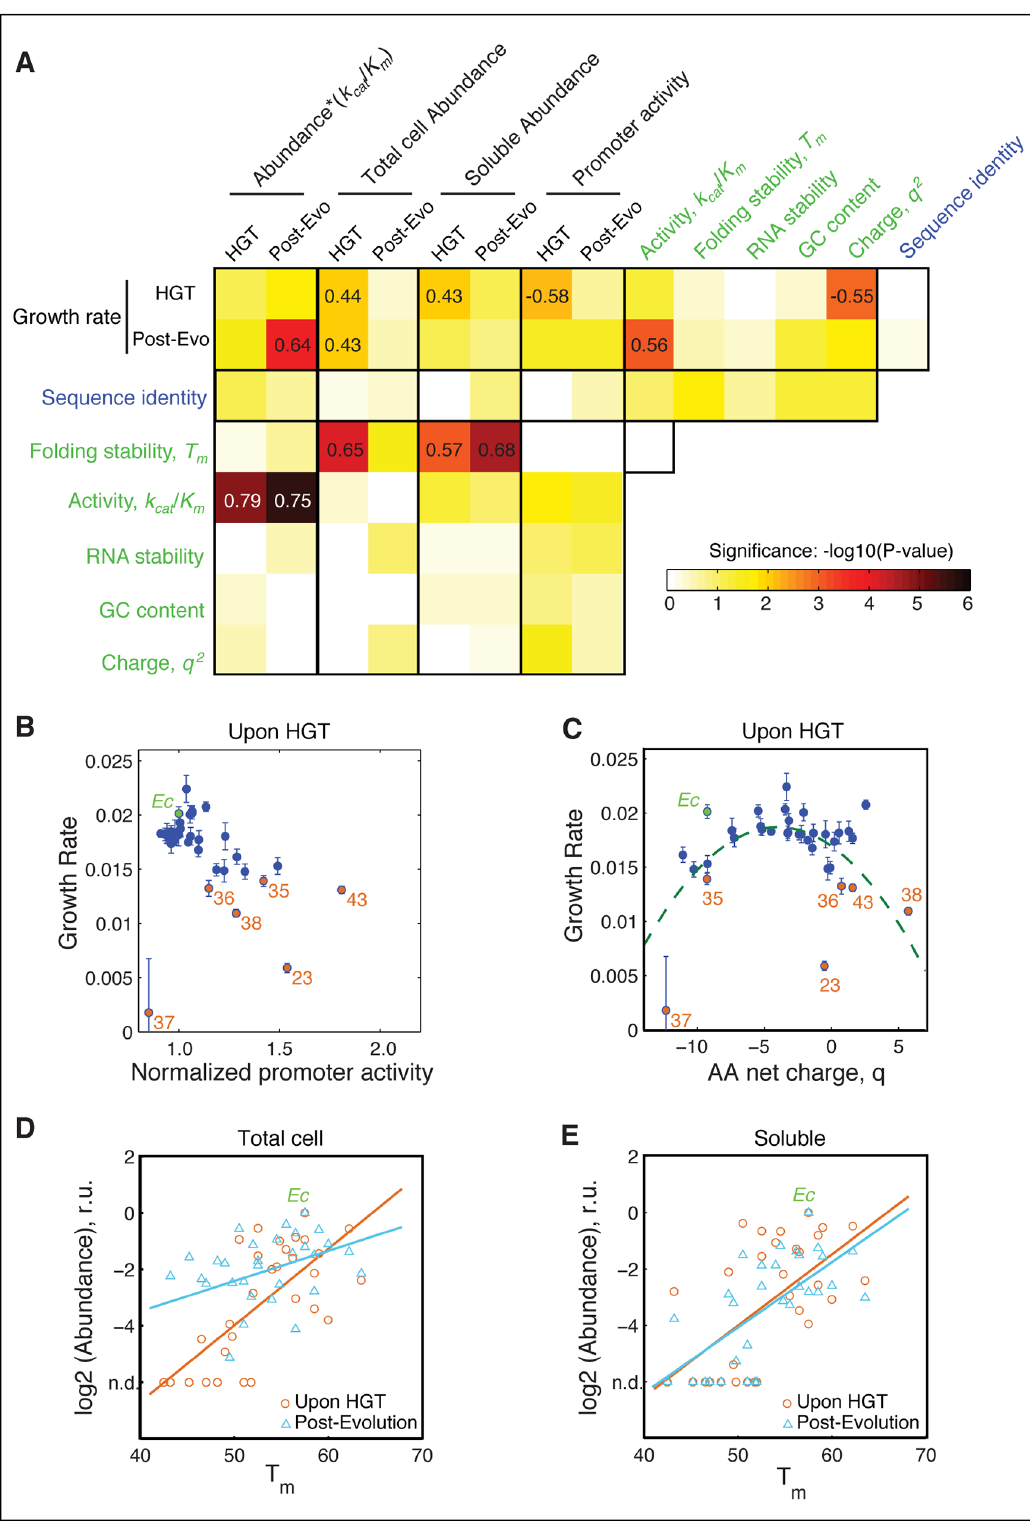
Fig 4. The role of molecular and cellular properties in the fitness effects of HGT. A) Correlation between growth rates, sequence and biophysical properties, and cellular responses (S1, S2 and S3 Tables) Blocks are colored according to − log10 ( p -values) of Spearman correlation.